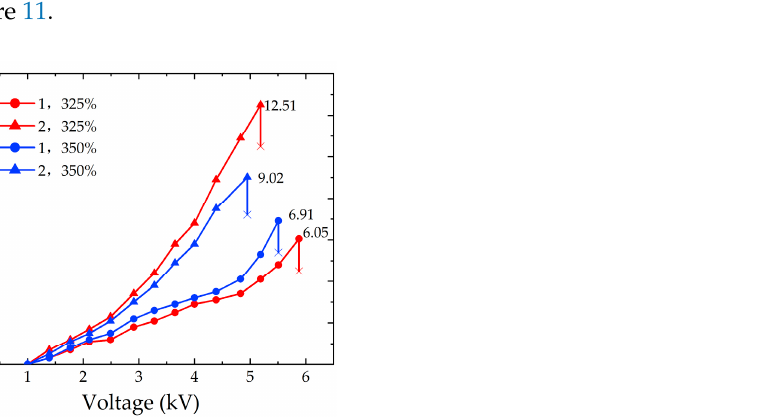
Figure 11. Experimental results of the different layers and the pre-stretching ratios of the DE mem- brane.